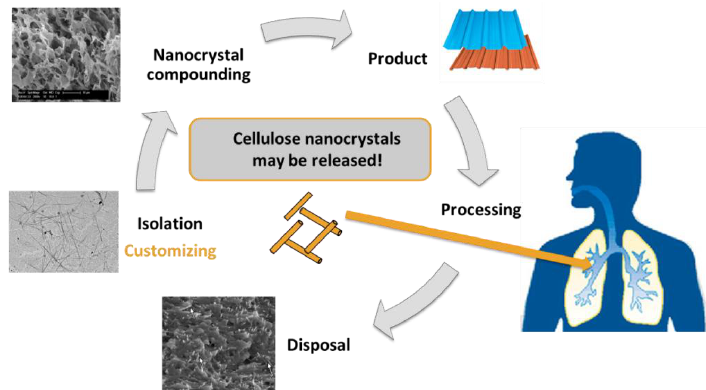
Figure 1. Schematic of the life-cycle of cellulose nanocrystals and products made from these nanoparticles. There are five main points in the life-cycle of CNCs; i. isolation, ii. compounding, iii. product formation, vi. post manufacturing processing and use, and v. disposal. All stages of the life-cycle pose a potential human exposure scenario for which both the exposure level and the hazard associated, and thus the risk of CNCs to human health, are currently not fully understood. It must be emphasized that inhalation exposure remains the assumed primary route of entry to the human body for CNCs.